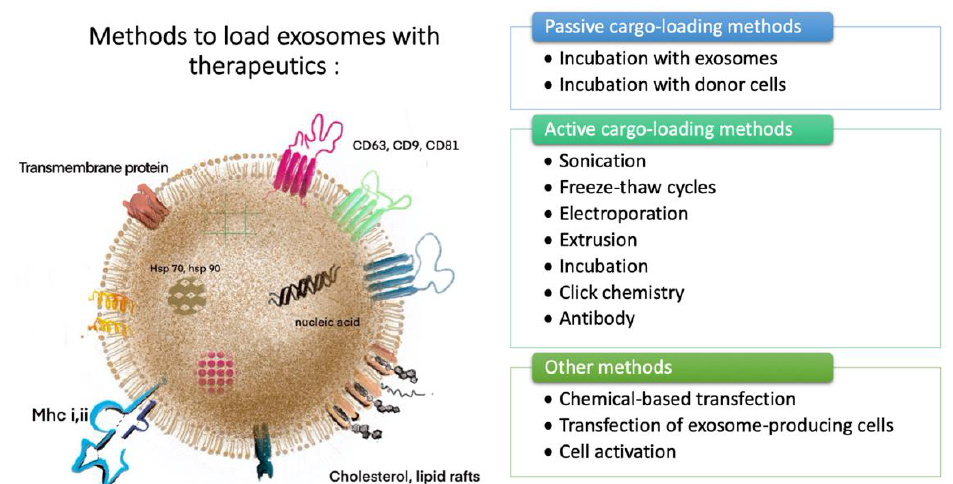
Figure 3. Summary of cell sources and methods used to isolate exosomes. ( A ) Sources of donor cells where exosomes have been isolated. ( B ) Methods of exosome isolation: ultrafiltration exosome isolation kits, polymer precipitation, differential centrifugation, and density-gradient centrifugation ultrafiltration [6,15,17].